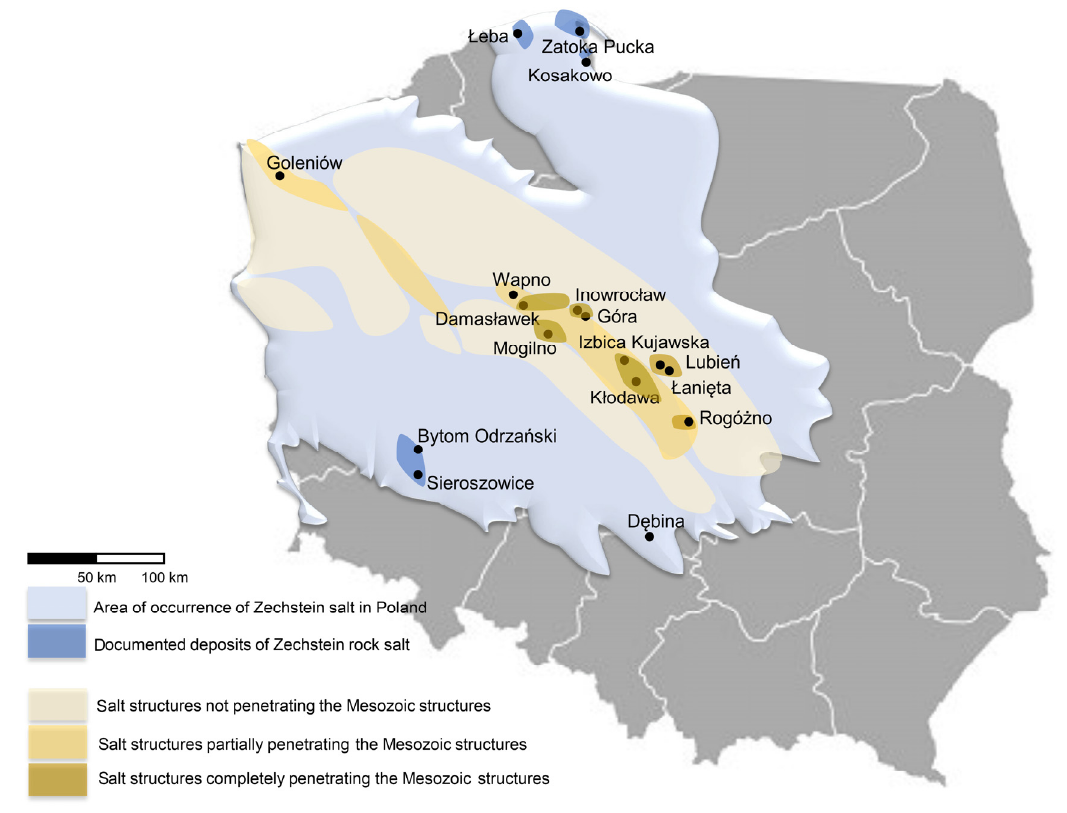
Figure 6. The map shows the diapir and stratified deposits located in Poland. The map also shows the prospective areas for the construction of salt caverns.